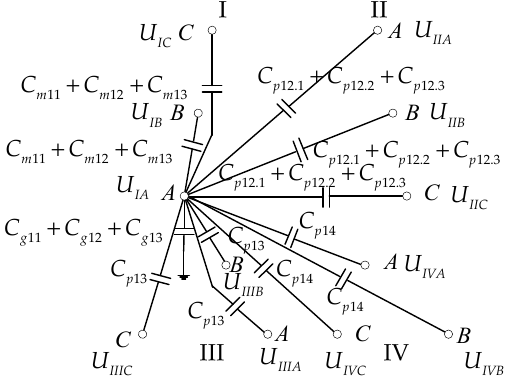
Figure 3. Simplified model of capacitance distribution between complex four-circuit lines on the same tower.